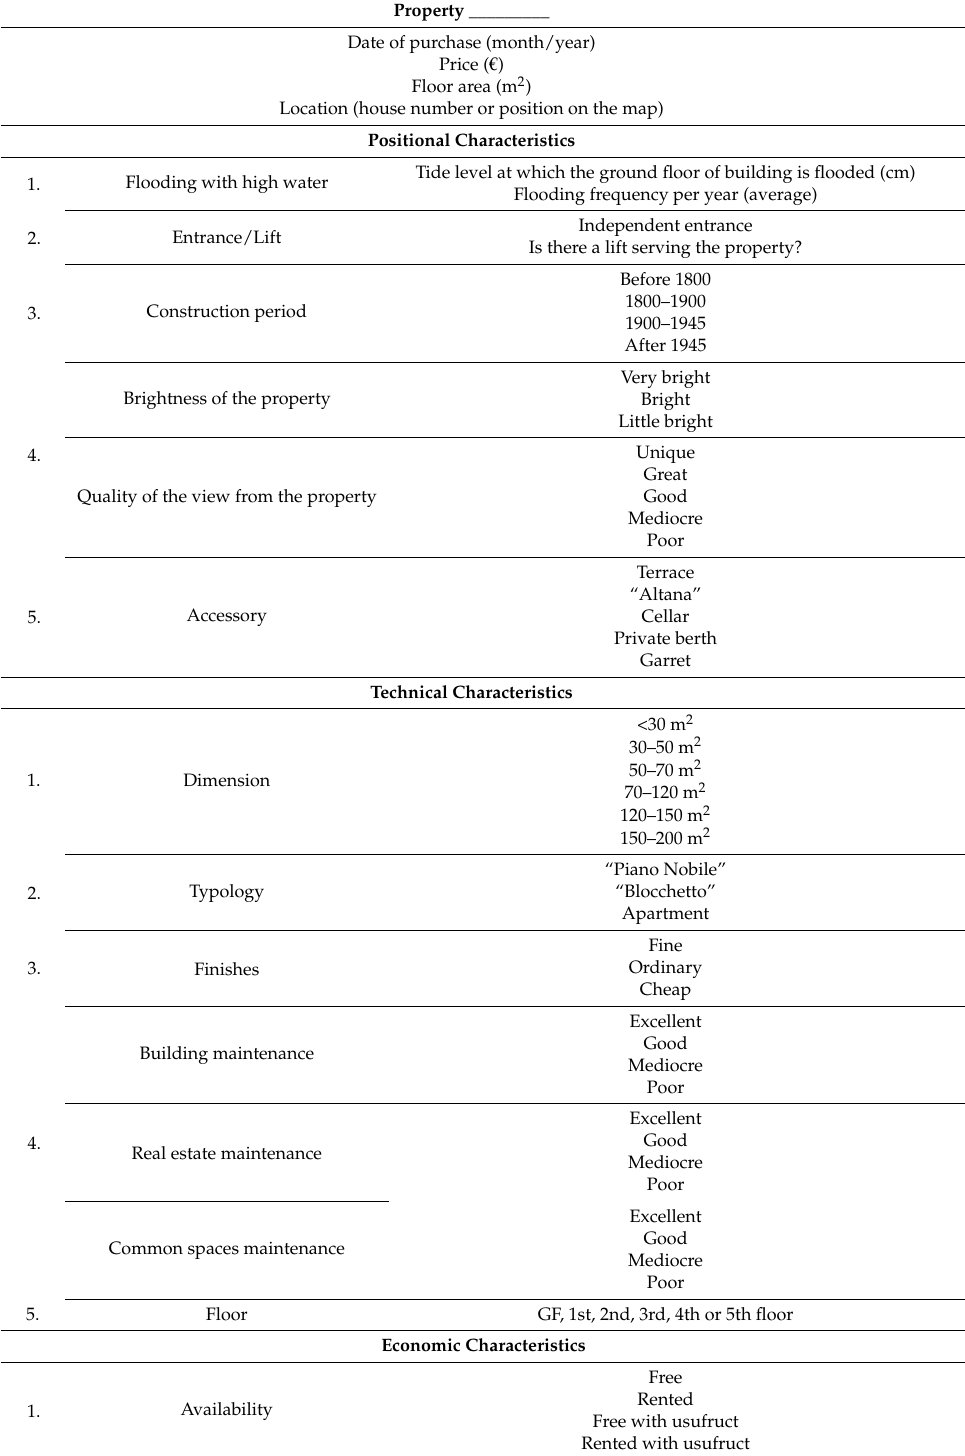
Table A1. Scheme for data